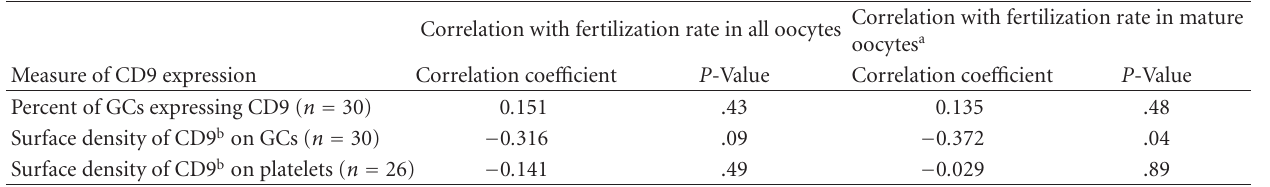
Table 1: Correlations between CD9 expression on human granulosa cells (GCs) and platelets and fertilization rates in oocytes. Correlation with fertilization rate in mature Correlation with fertilization rate in all oocytes oocytes a